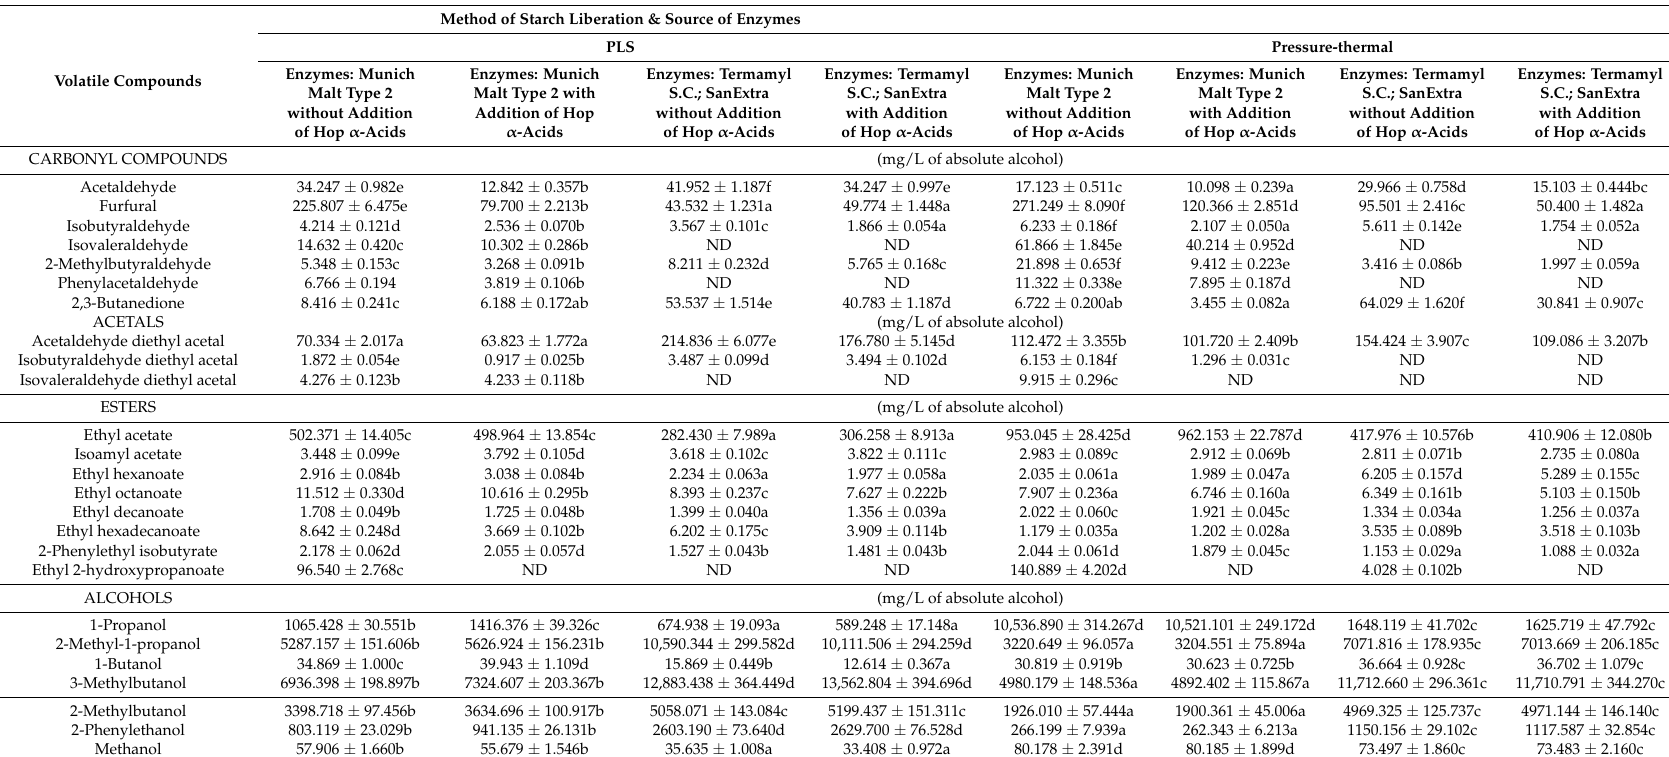
Table 7. Chemical composition of the obtained